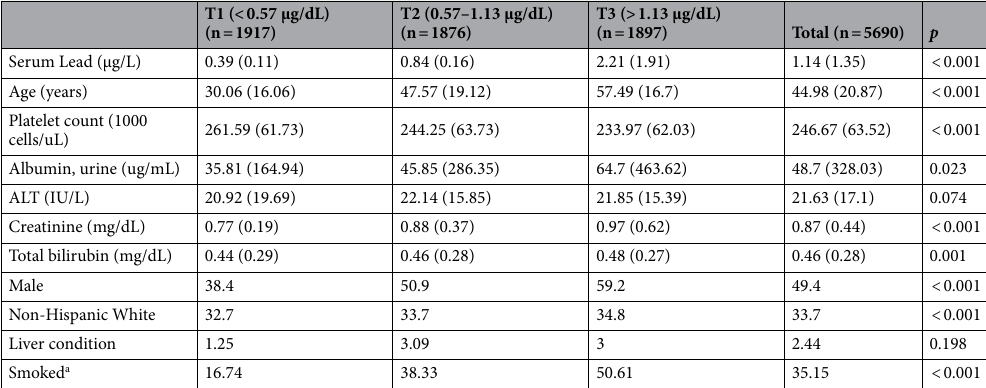
Table 2. Characteristics of study participants by tertiles of serum lead concentration (µg/L). a “Smoked” was defined as ever smoked at least 100 cigarettes in a lifetime.